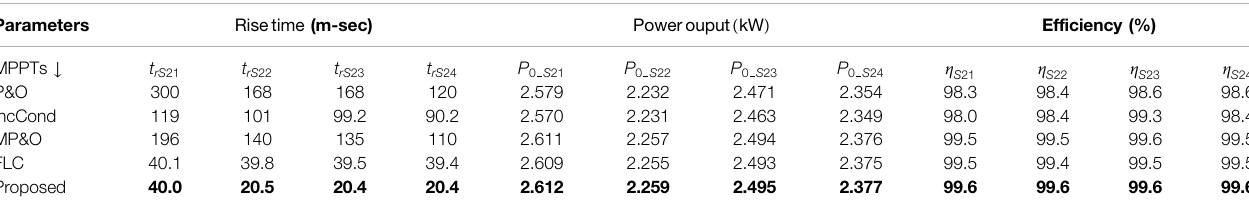
TABLE 4 | Performance comparison analysis of simulation results validated under scenario-II. Parameters Powerouput ( kW ) Efficiency